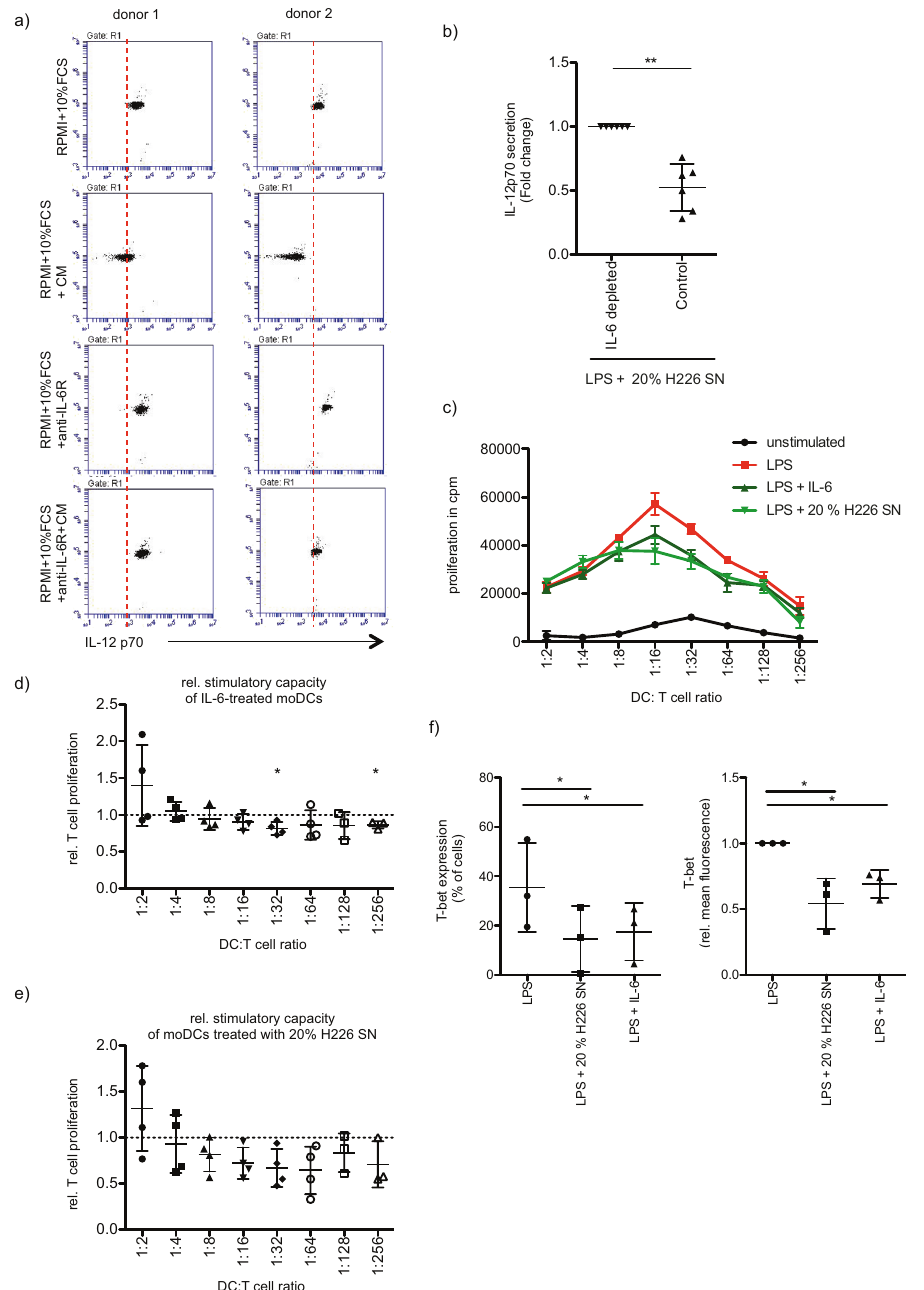
Fig. 3 IL-6 secreted by cancer cells affects moDC-induced Th1 differentiation. a MoDCs were differentiated and stimulated (LPS, 100 ng/ml, 48 h) in the presence or absence of 20% of NCI-H226 supernatant (SN). Stimulation of moDCs was additionally carried out in the presence or absence of tocilizumab (5 µg/ml, anti-IL-6R mAb). IL-12p70 secretion was analyzed by CBA assay. Shown are 2 independent experiments. b Same as in a, but moDCs were differentiated and stimulated (LPS, 100 ng/ml, 48 h) in presence of IL-6 depleted- or control- supernatant (SN) of NCI-H226. The relative IL12-p70 secretion is presented (mean fold change ± SD; n = 6). c A MLR was performed with allogeneic CD4 + T cells and moDCs differentiated and stimulated (LPS, 100 ng/ml, 48 h) in the presence or absence of IL-6 (20 ng/ml) or of 20% of NCI-H226 supernatant (SN). T cell proliferation was determined via 3 H-thymidine incorporation. Shown is a representative experiment. Error bars show the standard deviation of three technical replicates. d The induced T cell proliferation of IL-6-treated moDCs (20 ng/ml) (mean fold change ± SD; n = 4) and of e , moDCs treated with 20% of NCI-H226 supernatant (SN) was determined relative to the corresponding stimulated control (mean fold change ± SD; n = 4). f Naïve CD4 + T cells were expanded by stimulation with allogeneic moDCs, that have been differentiated and stimulated (LPS, 100 ng/ml, 48 h) in the presence or absence of IL-6 (20 ng/ml) or of 20% of NCI-H226 supernatant (SN). After restimulation of the CD4 + T cells with accordingly treated moDCs CD4 + T cells were stained for their T-bet expression. Shown is the percentage of the T-bet + population (mean ± SD; n = 3) and the relative mean fl uorescence of T-bet (mean fold change ± SD; n =